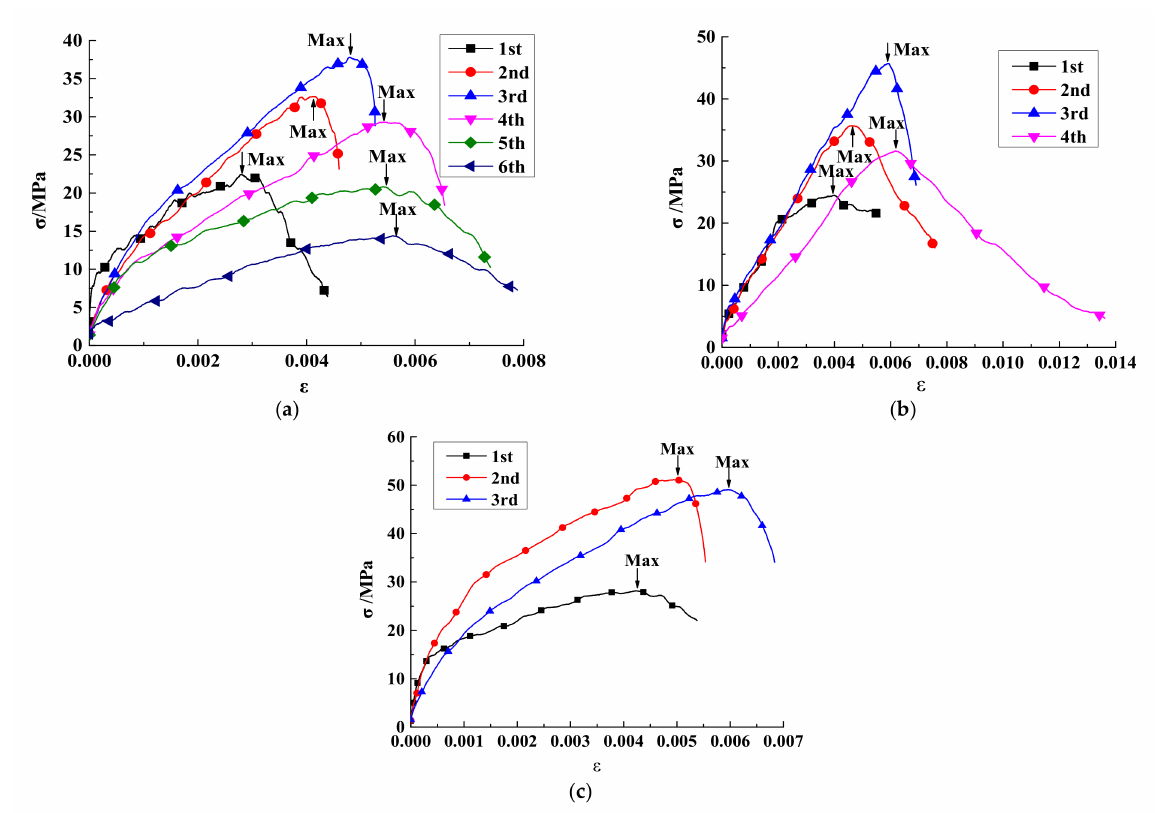
Figure 8. Stress–strain curves for the mudstone samples subjected to the cyclic-impact loading: ( a ) 0.15 MPa; ( b ) 0.175 MPa; ( c ) 0.20